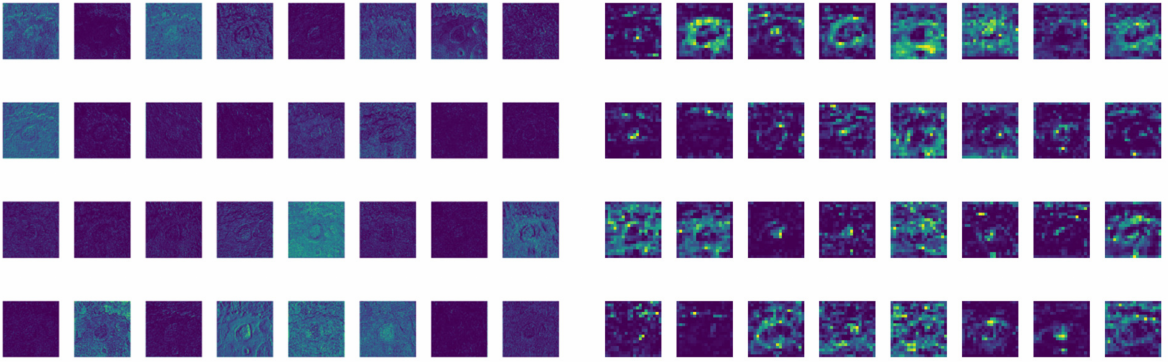
Figure 8. Visualization of the CSP1_X module and CSP3_X